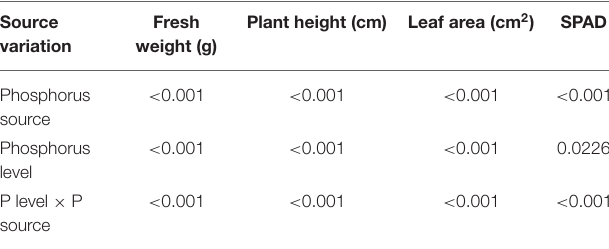
TABLE 2 | ANOVA analysis for Swiss chard grown in RP-enriched cow and pig manure vermicompost with Oxisol soil at week 8 after